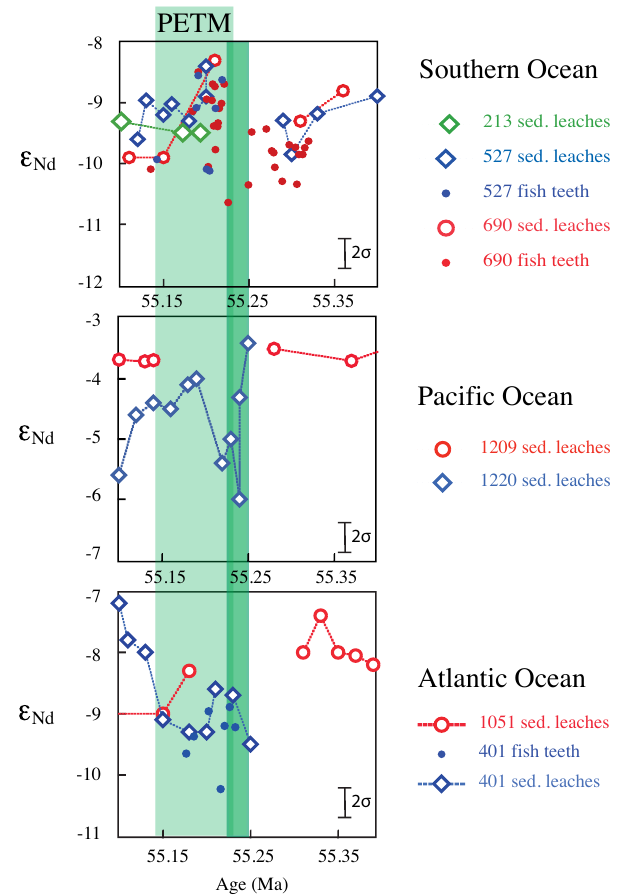
Figure 2. Sediment leach ε Nd and available fish teeth ε Nd data from 55.1 to 55.4Ma for all three ocean basins. Sediment ε Nd values are connected with a dotted line and fish teeth data are represented by unconnected dots. The light-green shaded area represents the PETM as defined by the carbon isotope excursion from each core. The dark-green shaded area reflects our interpretation of the “trigger”